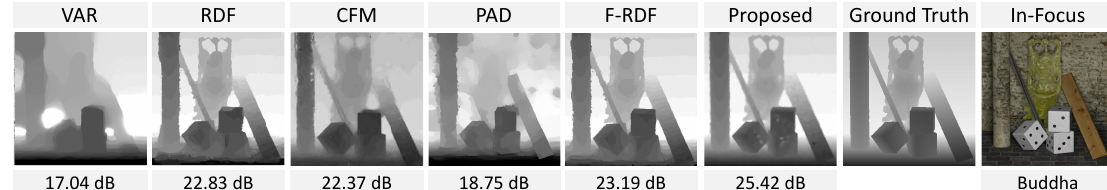
Figure 15. Quantitative evaluation on ‘Buddha’ synthetic sample (with 25 frames) with state-of- the-art methods. From left to right: Variational DFF (VAR) [1], Ring Difference filter (RDF) [19], Composite Focus Measure (CFM) [38], PAD method of multipliers (PAD) [39], Fast and noise robust RDF (F-RDF) [20], proposed, ground-truth, and in-focus image. The proposed method perform better than recent methods that visible in the images and reflected in the peak signal-to-noise ratio (PSNR) (in dB) shown below the each depth result. Note that depth image and PSNR value for CFM [38] was cropped from original paper.